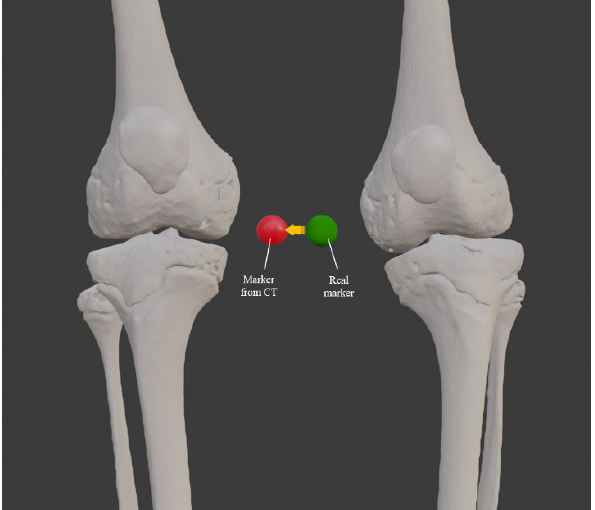
Figure 5. Flowchart describing the creation of OpenSim model using NmsBuilder and 3D TC models.